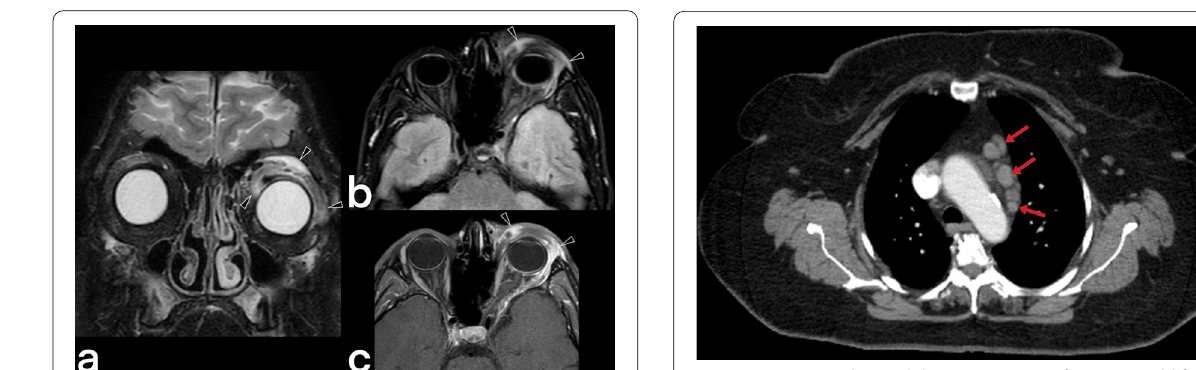
Fig. 16 Contrast-enhanced thorax CT image of a 70-year-old female. Multiple mediastinal lymphadenopathies are noted in the prevascular region (red arrows)